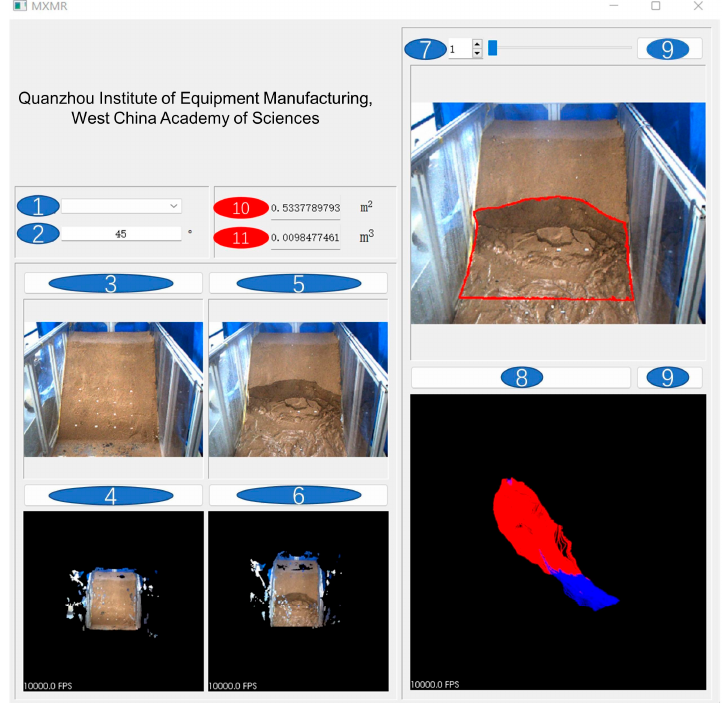
Figure 2. Landslide identification software. 1 Algorithm, 2 Slope angle, 3 Load T 0 moment image, 4 Load T 0 moment point cloud, 5 Load T n moment image, 6 Load T n moment point cloud, 7 Threshold, 8 Calculate, 9 Save, 10 Area, and 11 Volume.